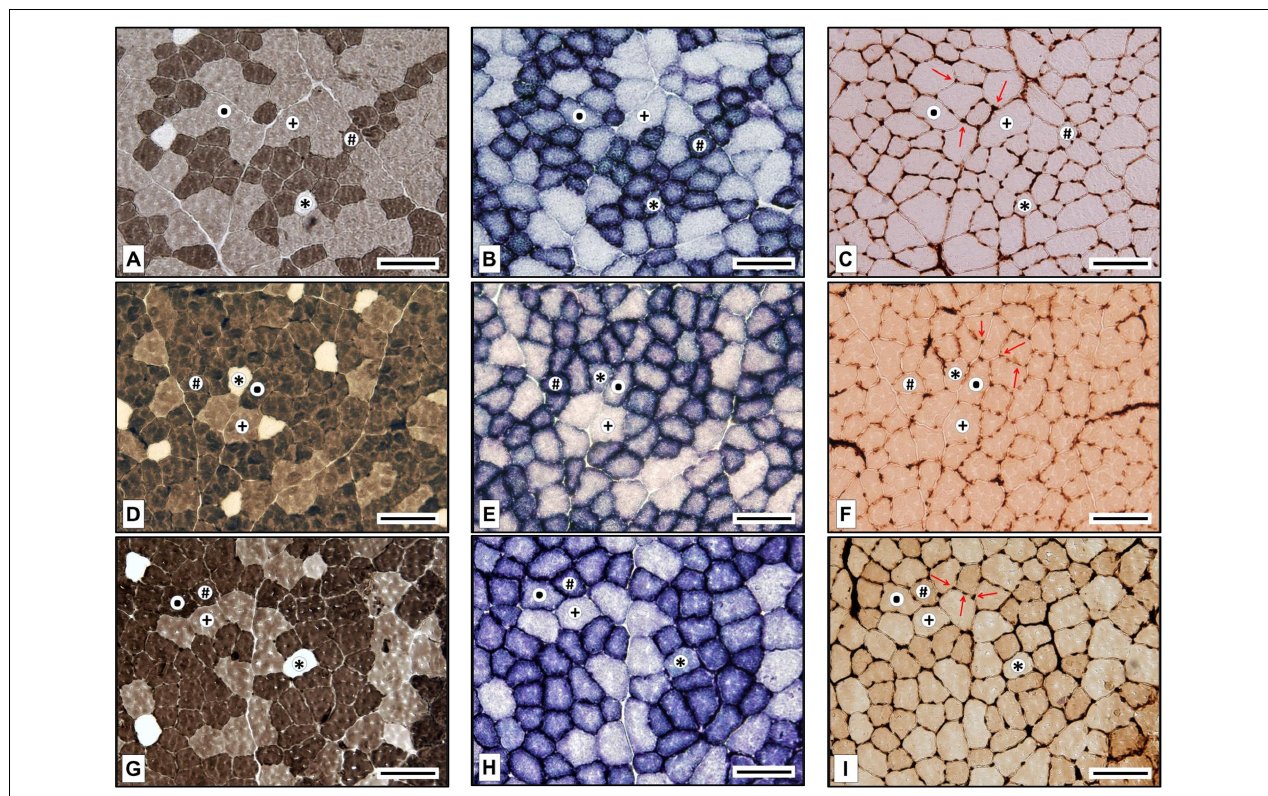
FIGURE 2 | Fiber types in the posterior field of the rat tibialis anterior muscle in Trained Normobaric Inactive (A–C) , Trained Hypobaric Inactive (D–F) , and Trained Hypobaric Active (G–I) animals. (A,D,G) Myosin ATPase (alkaline pre-incubation); (B,E,F) succinate dehydrogenase; and (C,F,I) endothelial ATPase (arrows indicate muscle capillaries). ∗ , slow oxidative (SO); #, fast oxidative glycolytic (FOG); • , fast intermediate glycolytic (FIG); † , fast glycolytic (FG). Scale bar, 100 µ m.